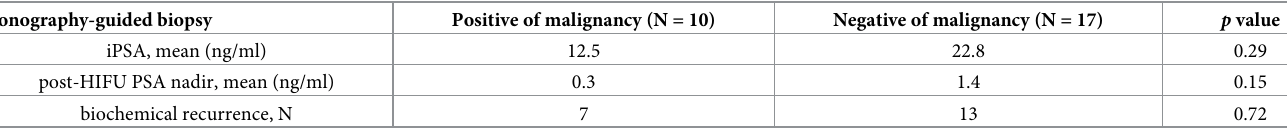
Table 6. Relationships between post-HIFU PSA and post-HIFU prostate biopsy. Sonography-guided biopsy